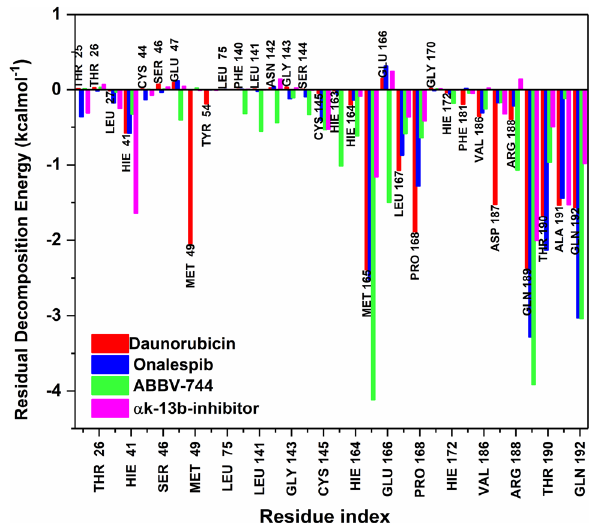
Figure 8. Per residual decomposition energy of selected compounds (Daunorubicin in red, Onalespib in blue, ABBV-744 in green and αk-13b inhibitor in magenta) bound to M pro enzyme calculated with MMGB/SA